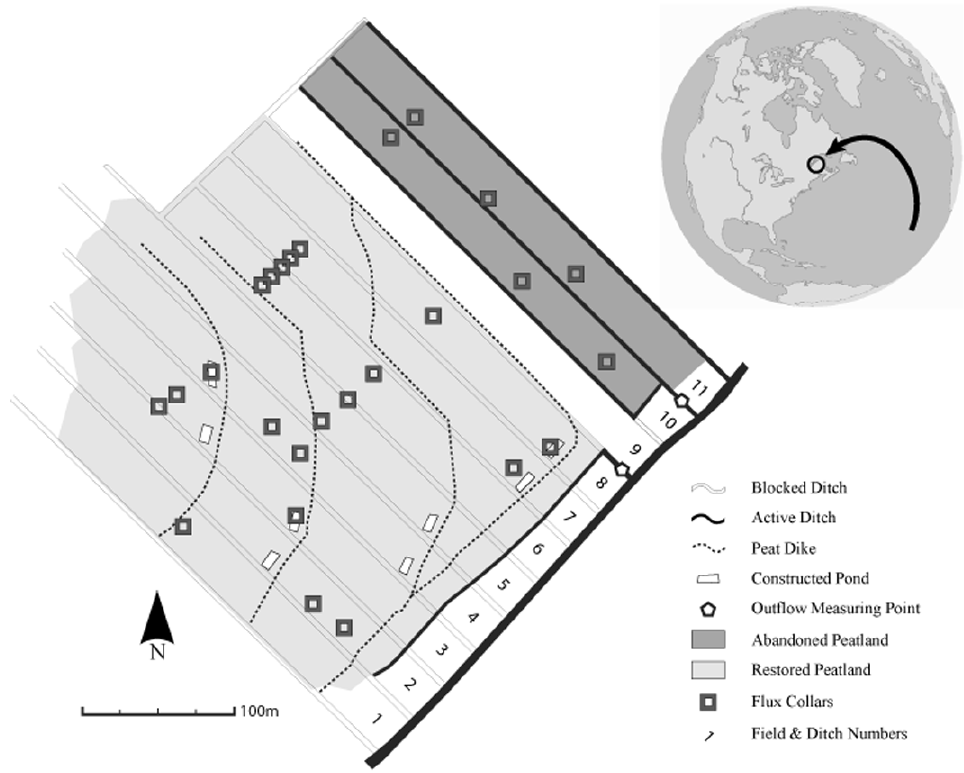
Fig. 1. Bois-des-Bel study site showing restored and unrestored (abandoned) sites. The natural site is located approximately 1.7km west of the restored site in the neighboring undisturbed